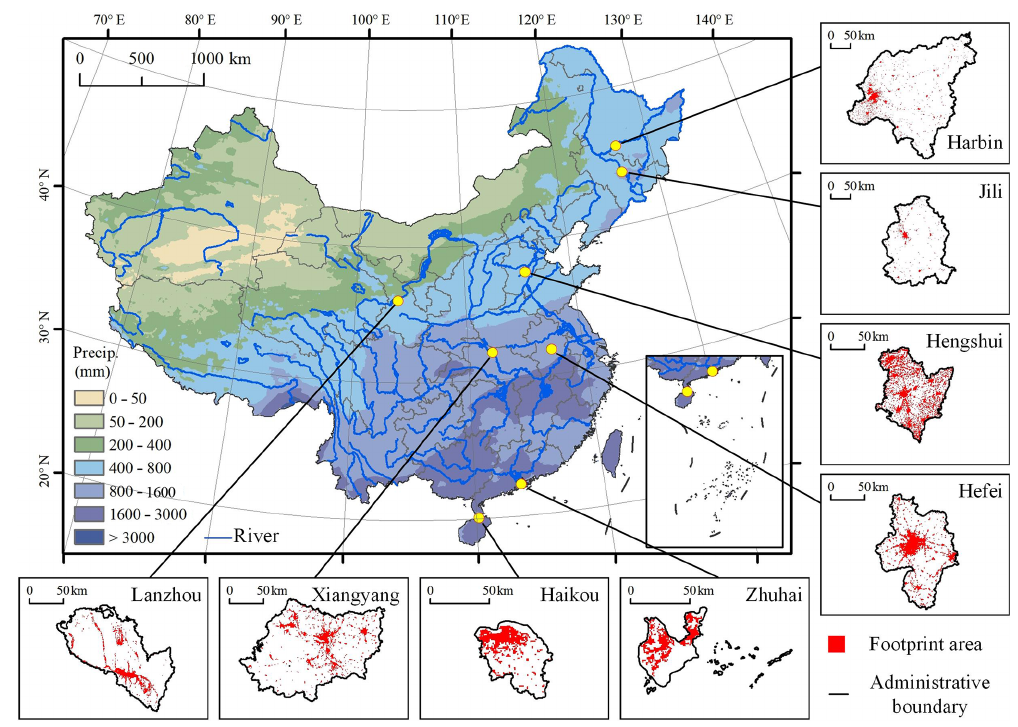
Figure 1. A map showing the geographic locations, annual precipitation, and footprints of the eight cities in this study.